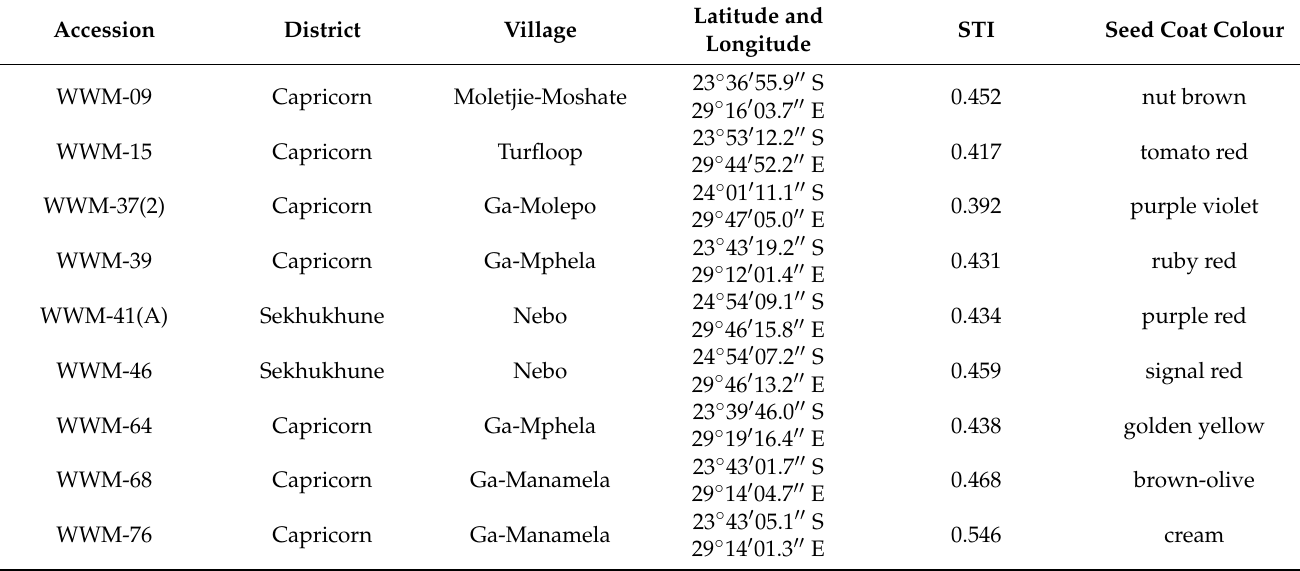
Table 7. Information on the source of seed, drought stress tolerance index and seed coat colour of citron watermelon accessions used in the